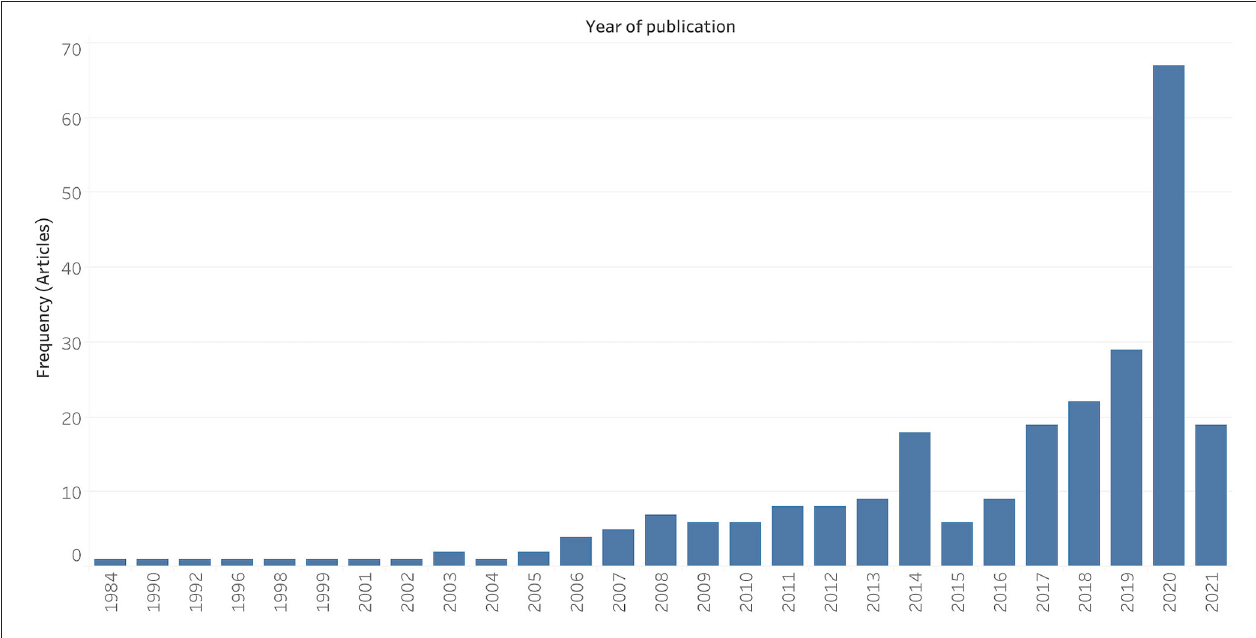
FIGURE 1 | Publication trend of neurosurgery survey